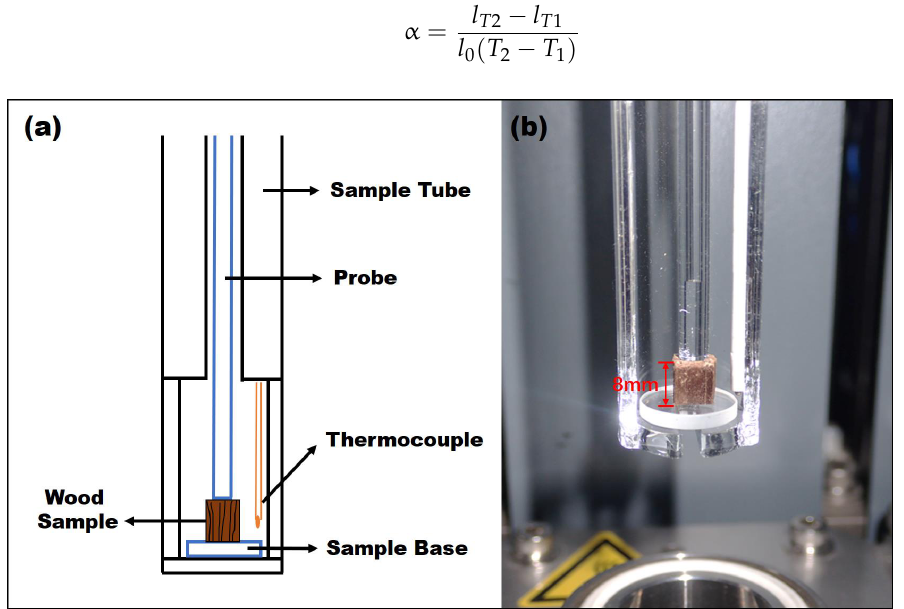
Figure 4. Linear expansion coefficient of archaeological wood tested with TMA: ( a ) linear expansion test components; ( b ) image of linear expansion